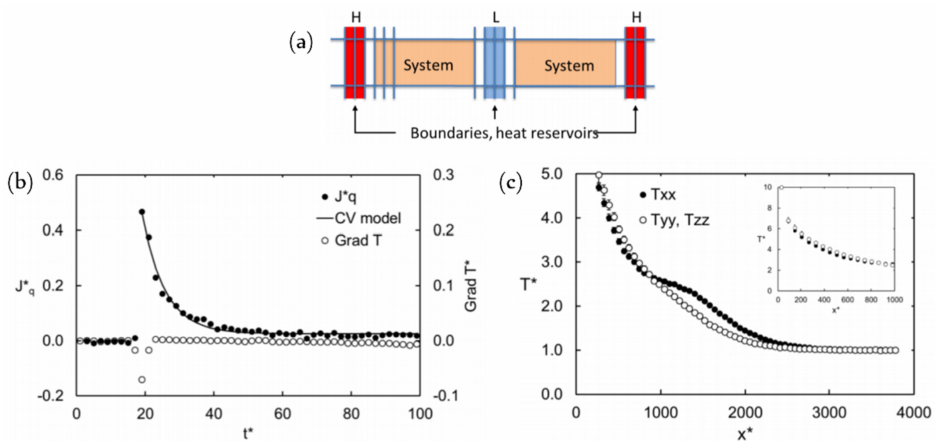
Figure 10. ( a ) NEMD cell layout, ( b ) transient function of thermal boundary conditions, ( c ) local temperature tensor components at t = 400 from the non-equilibrium simulation in the diluted gas case. The system obeys the ideal gas law. N particles = 432,000. (For in-depth interpretation of these data, readers are referred to the paper of Hafskjold